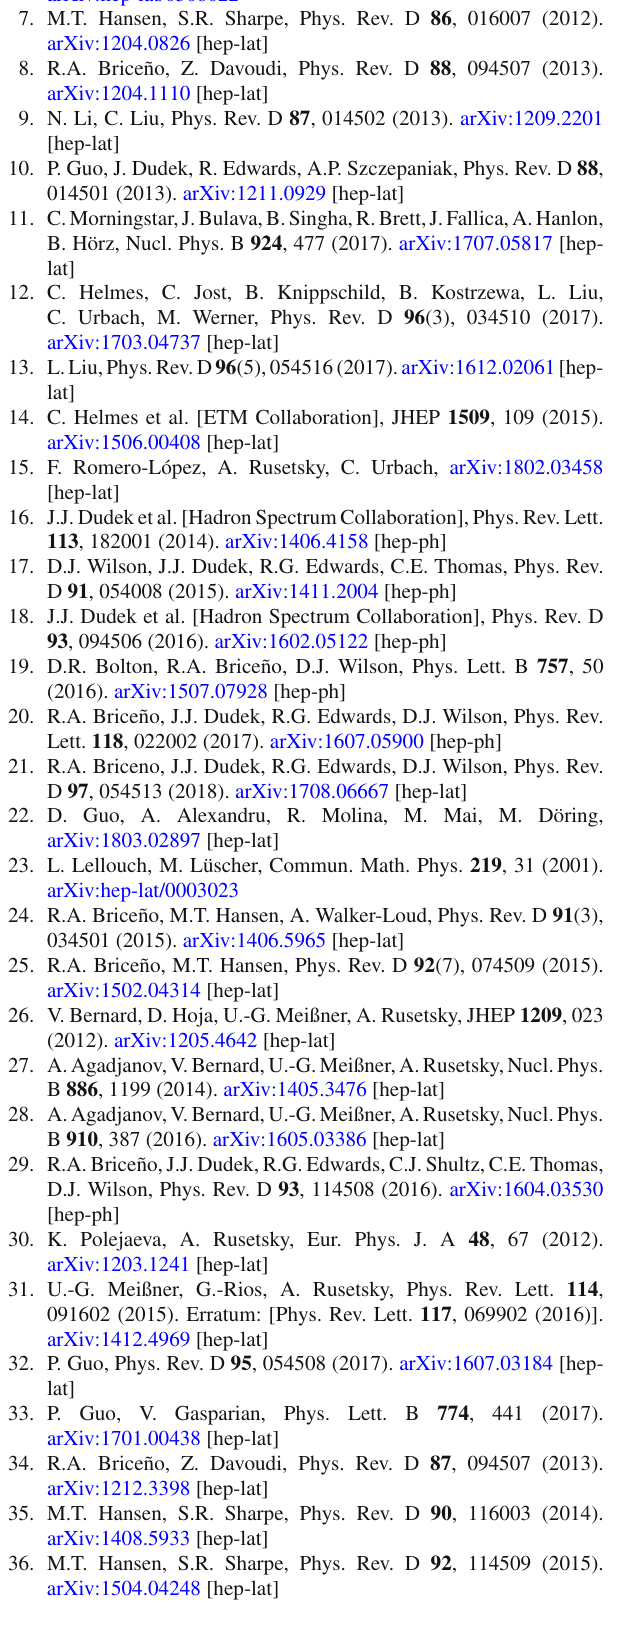
Table3 Phaseshiftindegrees, obtainedfrom Eq.(39). Thesmallvalue ensures perturbability